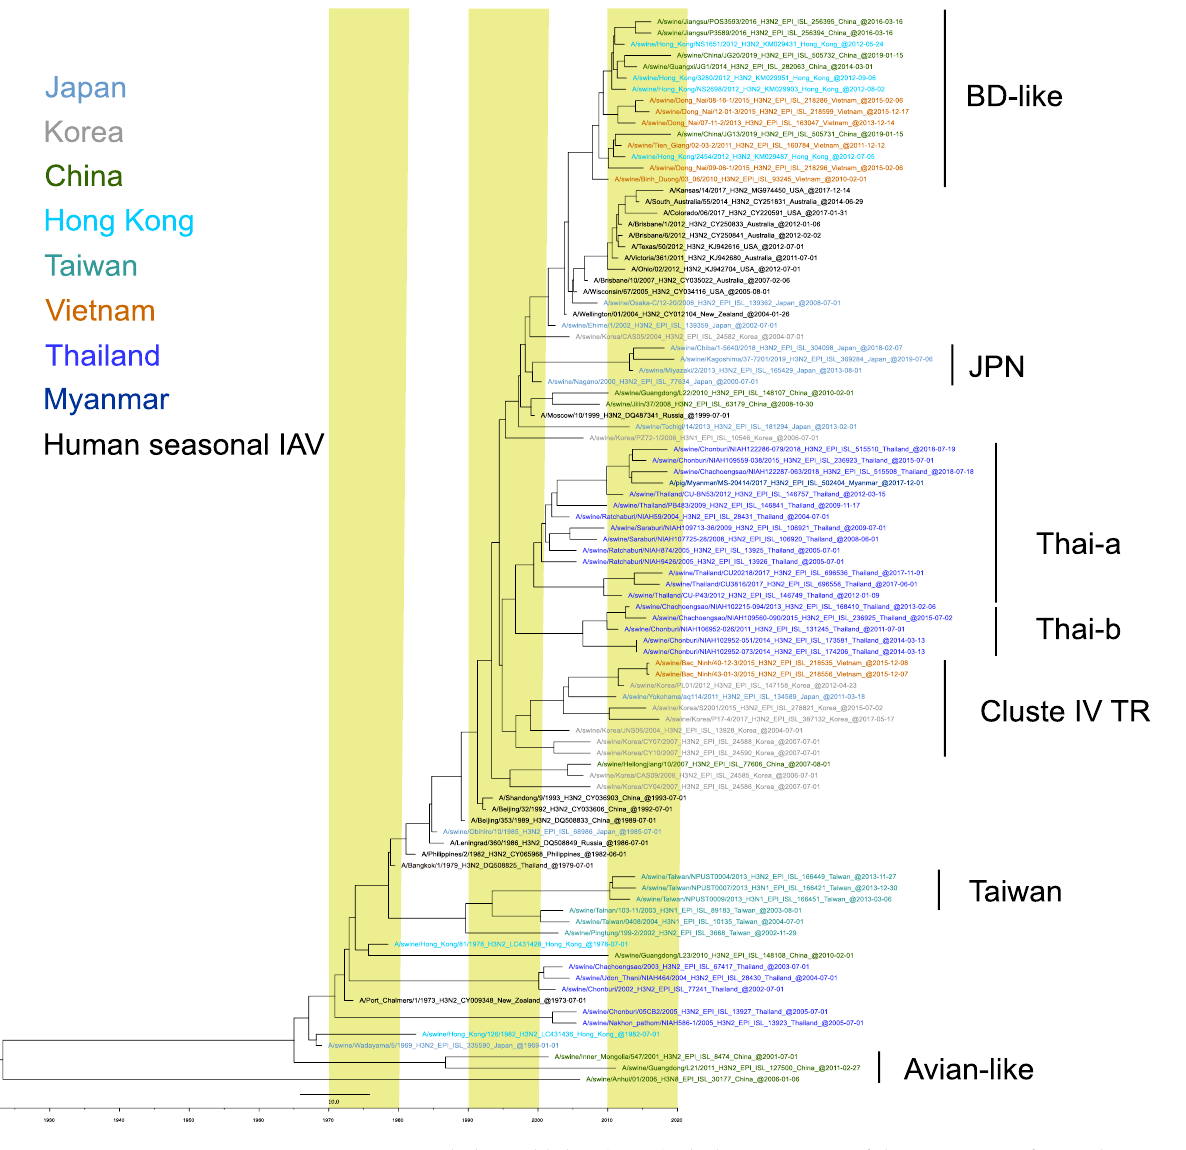
Figure 4. Maximum clade credibility (MCC) phylogenetic tree of the HA genes of H3 subtype Asian IAVs-S. All available H3 HA gene sequences with complete HA coding regions from IAVs-S isolated in the nine Asian countries in Figure 2 were downloaded from GISAID on 8 July 2021. Sequence data from the Philippines and Indonesia were unavailable at the time of the download. Sequence data for each country or region underwent cd-hit clustering [69] (threshold, 98.5% identity) to reduce the number of sequences and increase visualization. Countries and regions are defined as in Figure 3. For the calculation, when only the year was available as the isolation date from GISAID, 1 July was used as the tentative isolation date; when only the year and month were available, the 15th was used as the day. This tree was constructed to illustrate the overall evolutionary pathway of Asian IAVs-S, not for precise calculation of the divergence time. Various human seasonal IAVs and IAVs-S from other countries have been included as clade indicators.